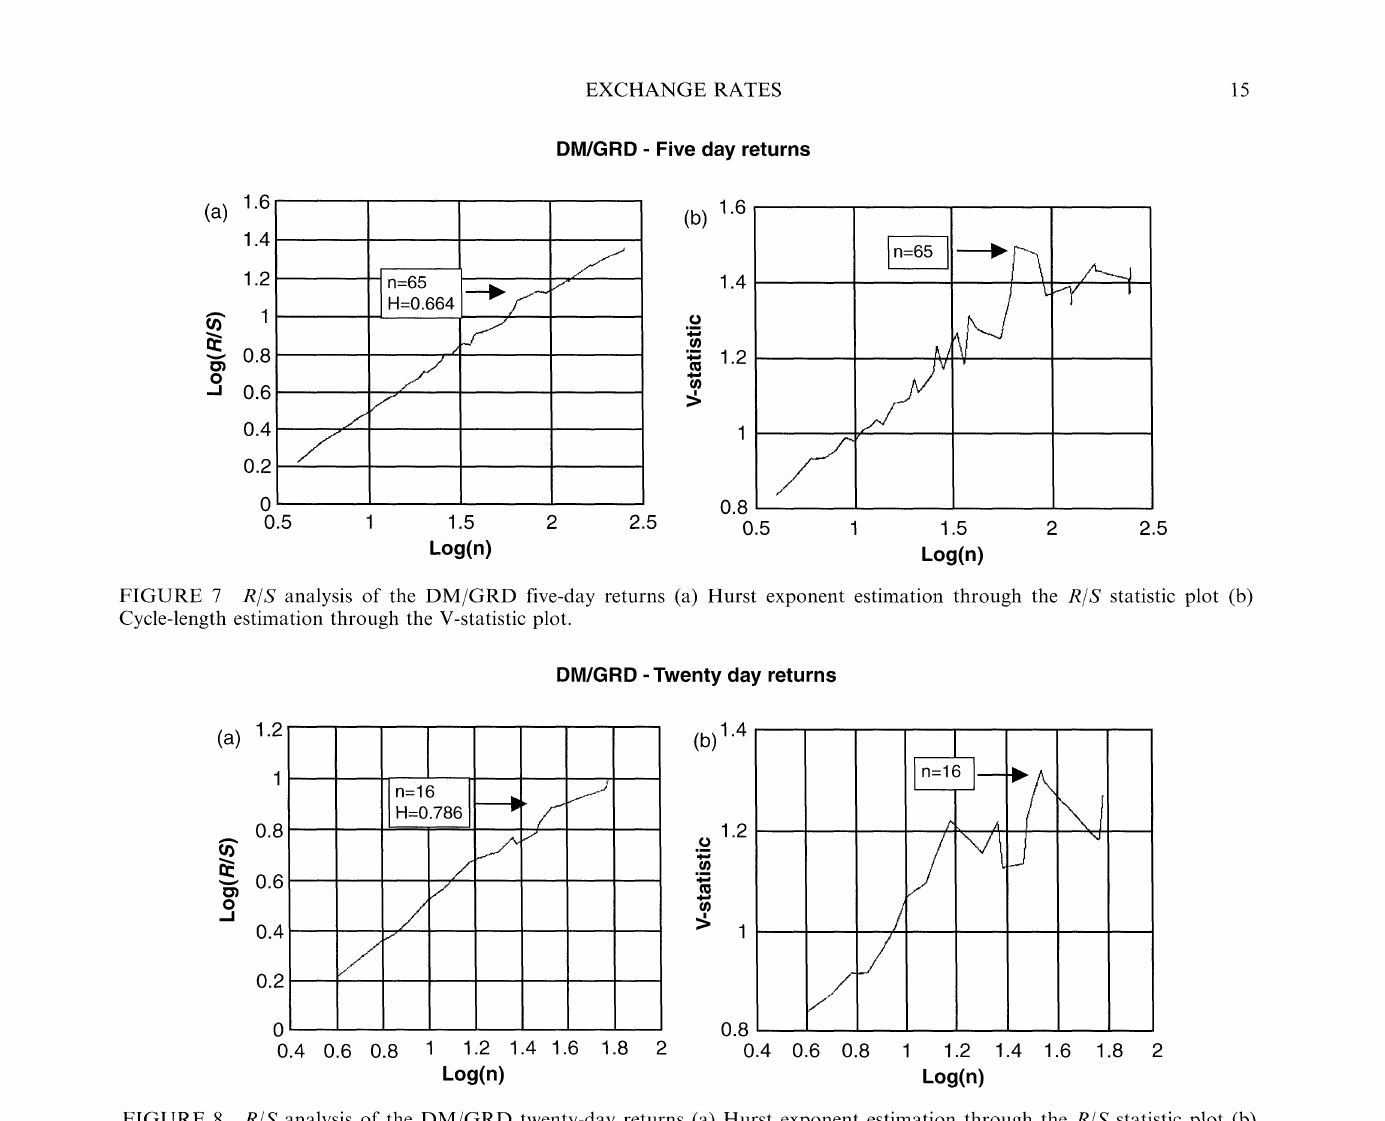
FIGURE 8 R/S analysis of the DM/GRD twenty-day returns (a) Hurst exponent estimation through the R/S statistic plot (b) Cycle-length estimation through the V-statistic plot. TABLE XI Hurst estimates and test of significance against the iid random alternative of the five-day and 20-day DM/GRD